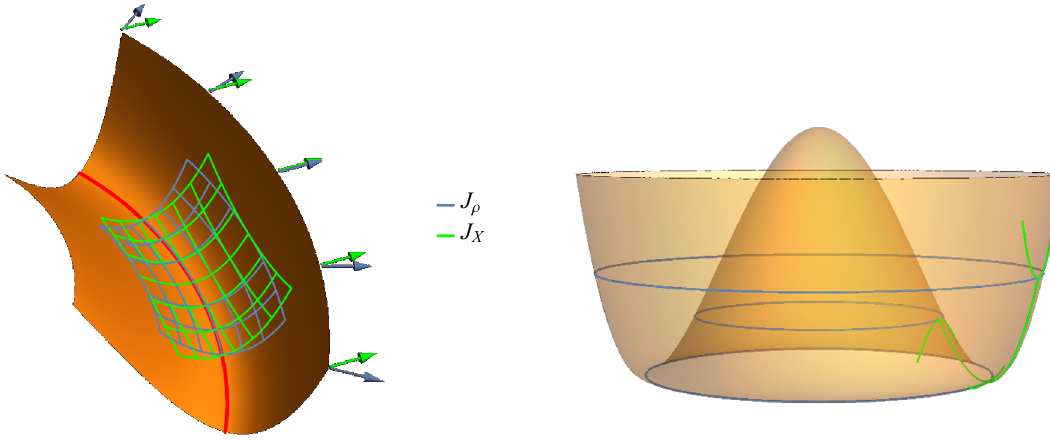
Figure 2 . Left panel: a wise coordinate choice induces a symmetric background current. The green lines correspond to Cartesian coordinates while blue lines correspond to polar coordinates. In turn, J X breaks U(1) while J ρ preserves it. Right panel: in polar fields, the Goldstone direction is flat thus massless. In contrast, in Cartesian fields, the Goldstone is generally massive away from the